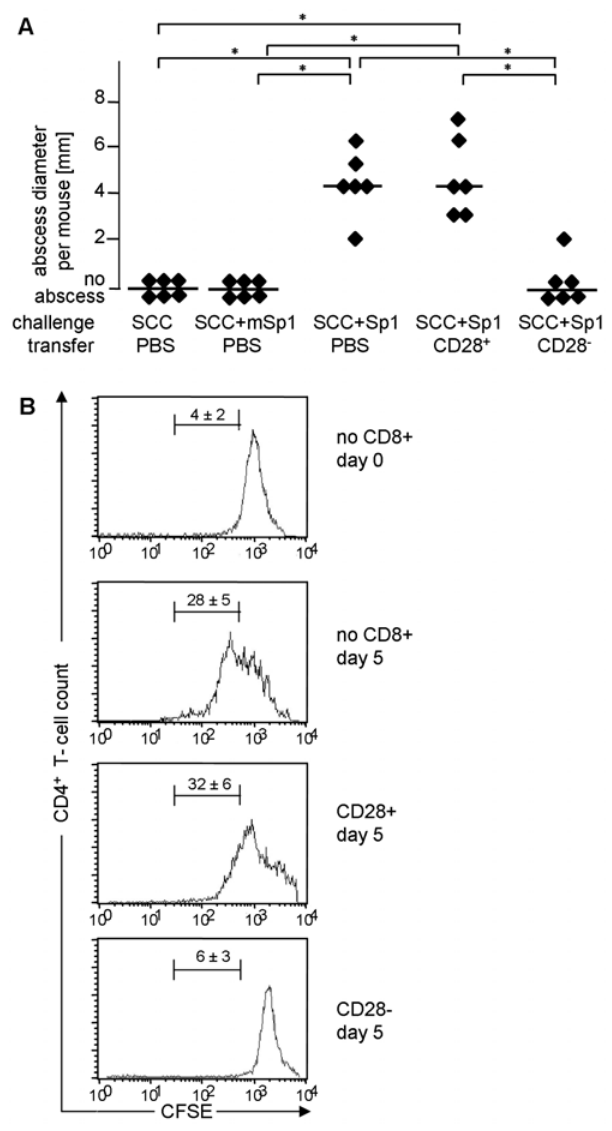
Figure 3. Sp1-induced CD8 + CD28 2 T lymphocytes suppress CD4 + T cell immune responses invivo and invitro . A. Sp1-induced CD8 + CD28 2 T lymphocytes suppress intraperitoneal abscess formation. C57BL/6 mice received intraperitoneal Sp1 challenge (100 m g), and challenge with mSp1 (100 m g), or, SCC adjuvant alone as controls, in the presence or absence of simultaneous intraperitoneal administration